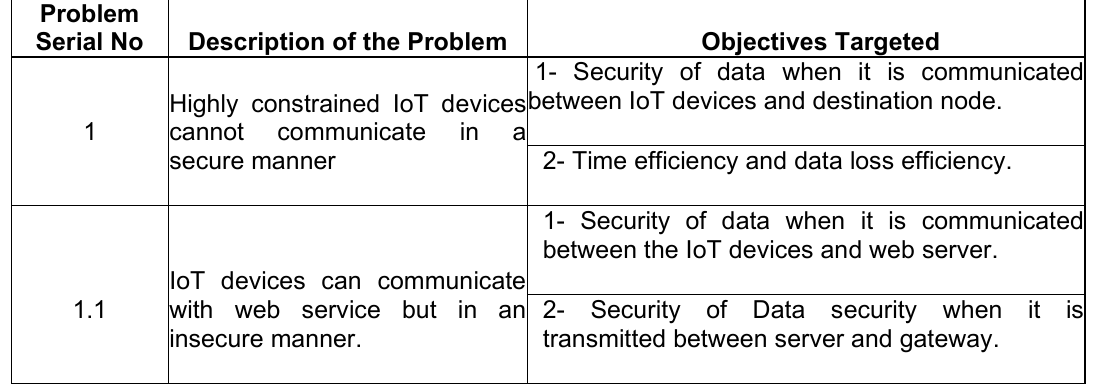
Table 3. Consideration for System